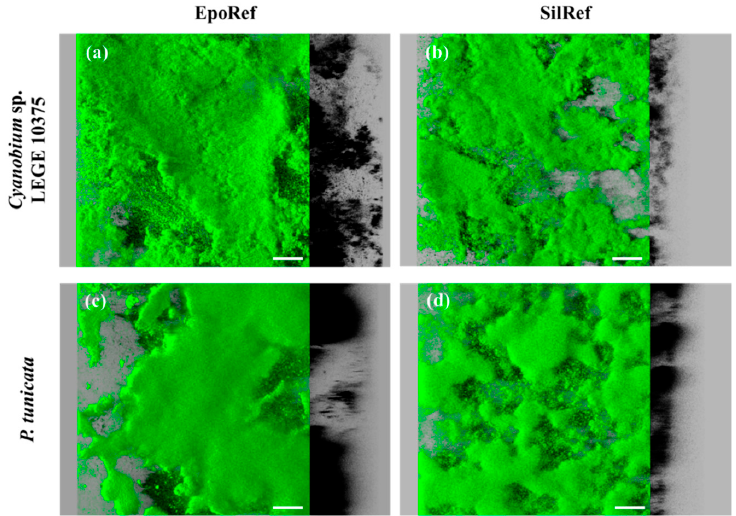
Figure 4. Representative biofilm structures of ( a ) Cyanobium sp. LEGE 10375 on EpoRef surface, ( b ) Cyanobium sp. LEGE 10375 on SilRef surface, ( c ) Pseudoalteromonas tunicata on EpoRef surface, and ( d ) Pseudoalteromonas tunicata on SilRef surface after 49 days of biofilm formation. These images were obtained from confocal z -stacks using IMARIS software and present an aerial, 3D view of the biofilms (shadow projection on the right). The scale bar is 50 µm.